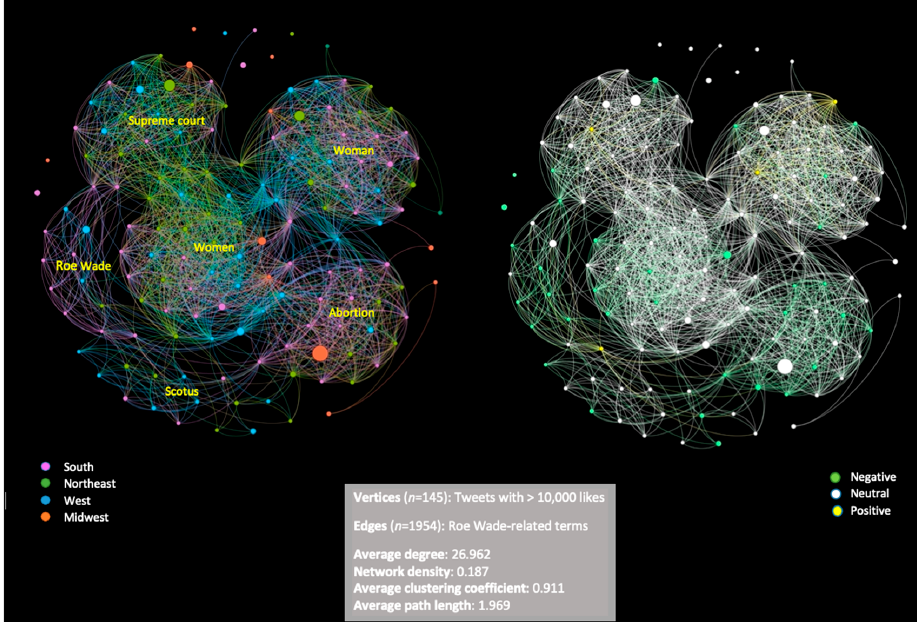
Figure 8. Network of Roe Wade-related Tweet Hubs by U.S. regions and Sentiment (May–July 2022) .